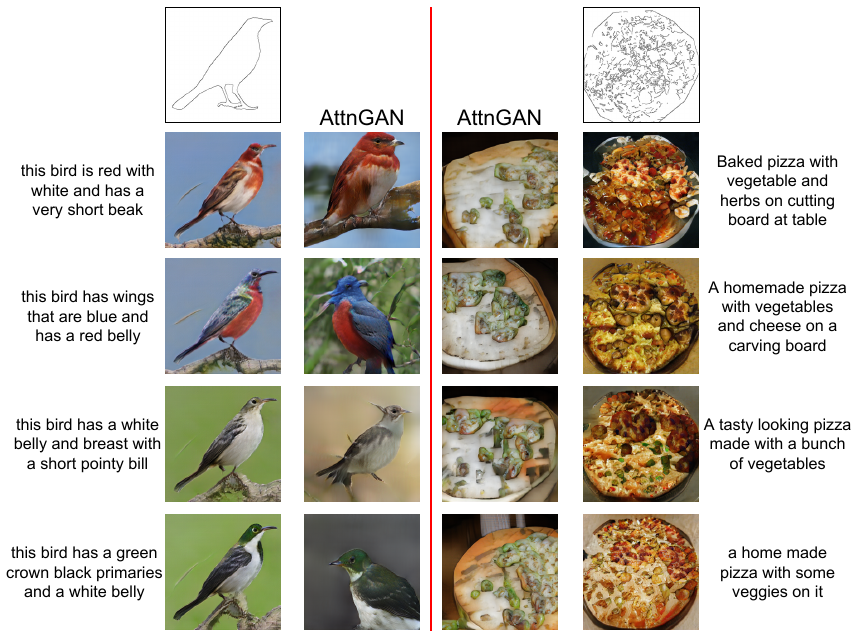
Figure 6. The qualitative comparison results between AttnGAN [5] and our customizable synthesis method on the CUB and MS COCO datasets are shown